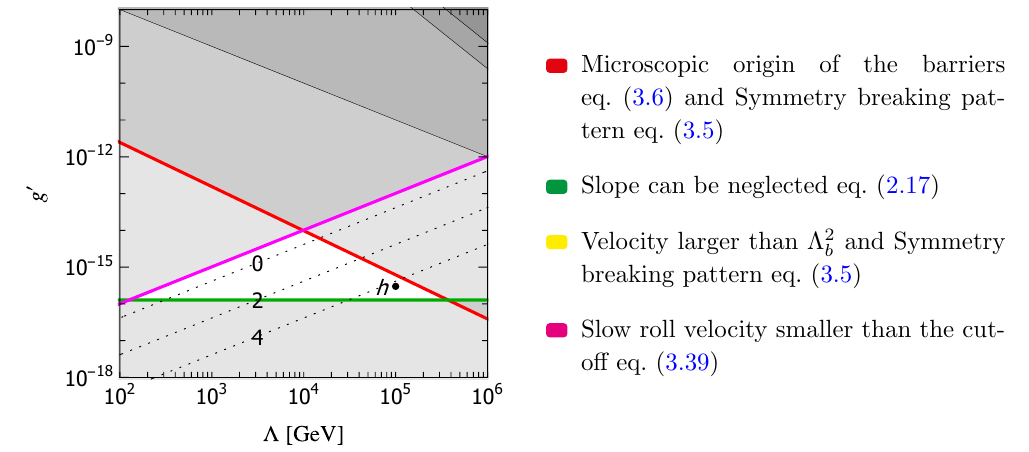
Figure 28 . Allowed parameter space in the plane g 0 ; (cid:3) for the case discussed in section 3.3, of a self-stopping relaxion, where the relaxion dominates the energy density of the universe during relaxation and drives an in(cid:13)ationary period. The dotted lines are the contours of number of efolds of in(cid:13)ation, log ( N efolds ). 10